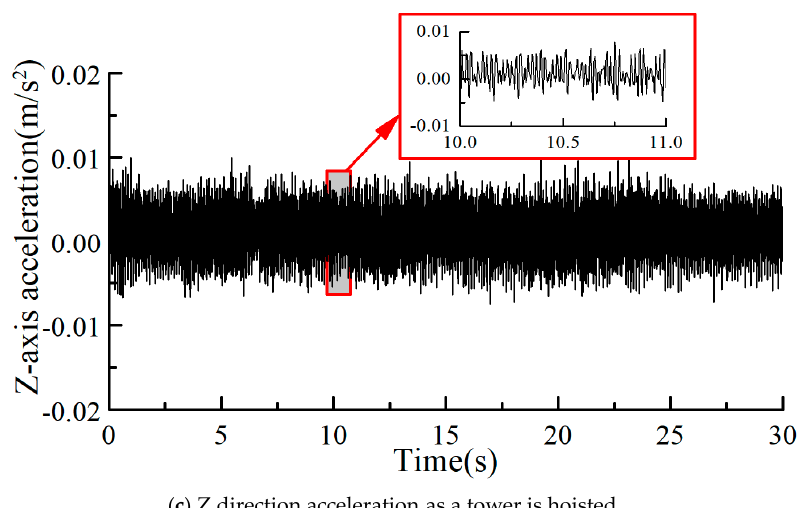
Figure 7. The three-axis acceleration data for the vessel’s motion as a tower is hoisted.